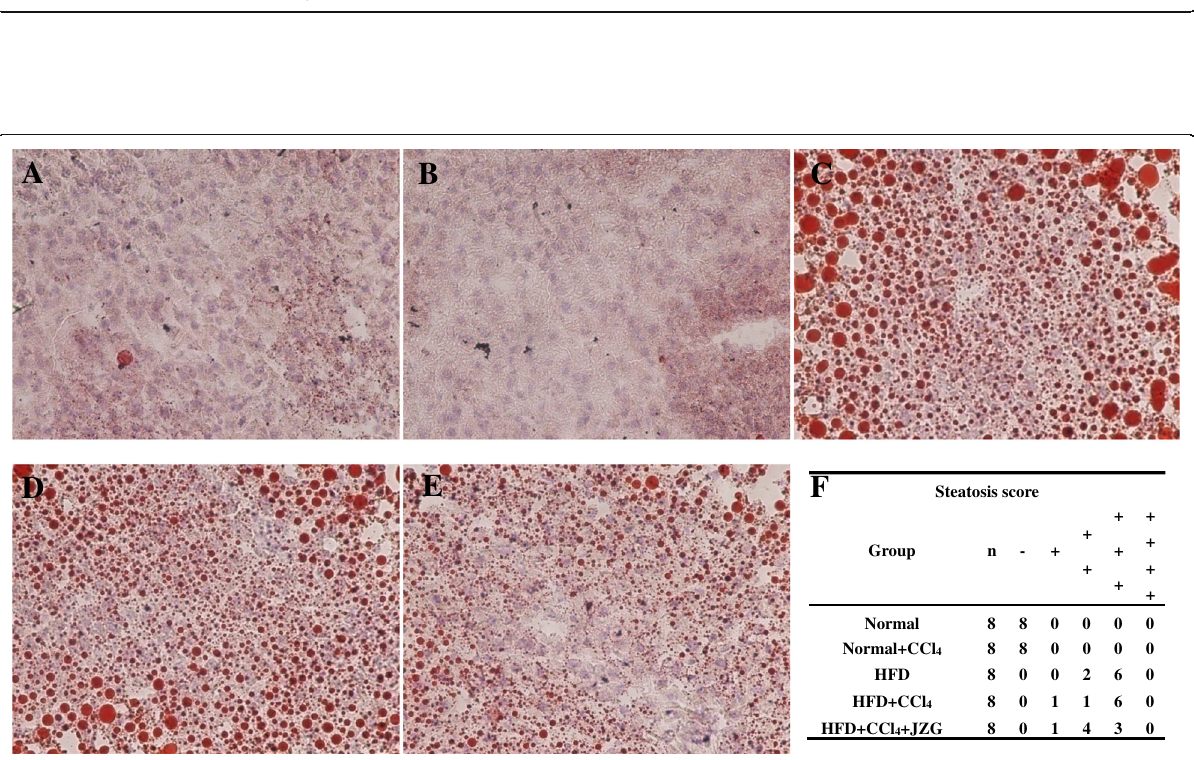
Fig. 2 Effect of JZG on liver function: a The serum ALT level, b The serum AST level, c The serum ALB level, d The serum γ -GT level. The values represent the mean ± SD. ( N = 8 per group